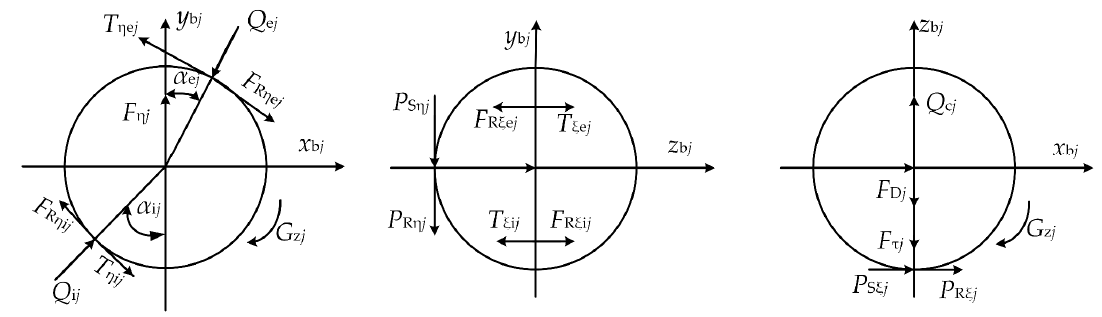
Figure 2. The forces acting on the loaded balls.